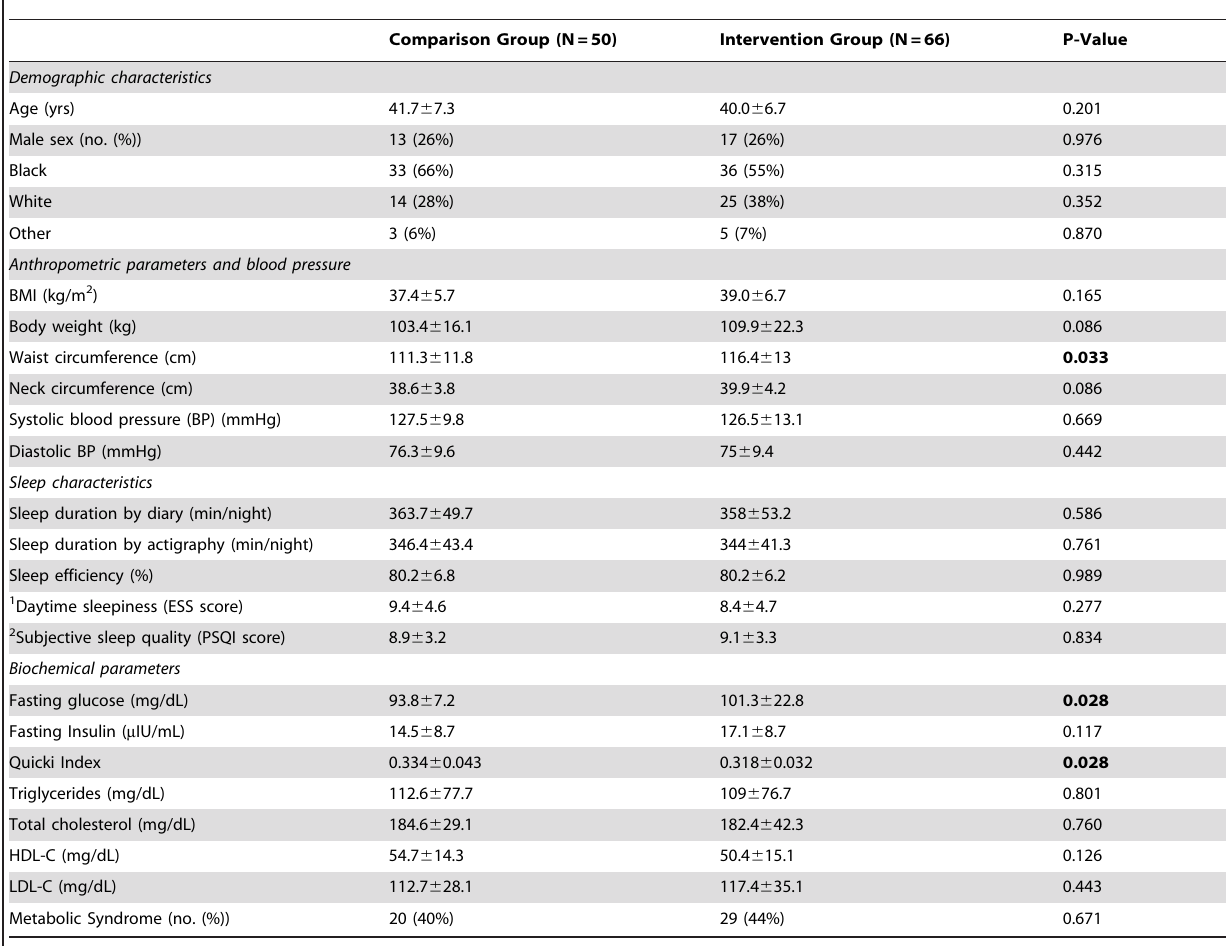
Table 2. Characteristics at screening (Visit 1) of participants who completed